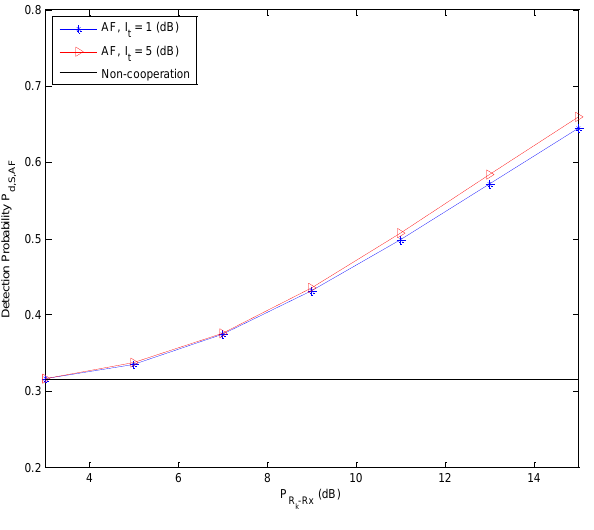
as a function of the received power d,S,AF in the AF-CSS scheme (P k